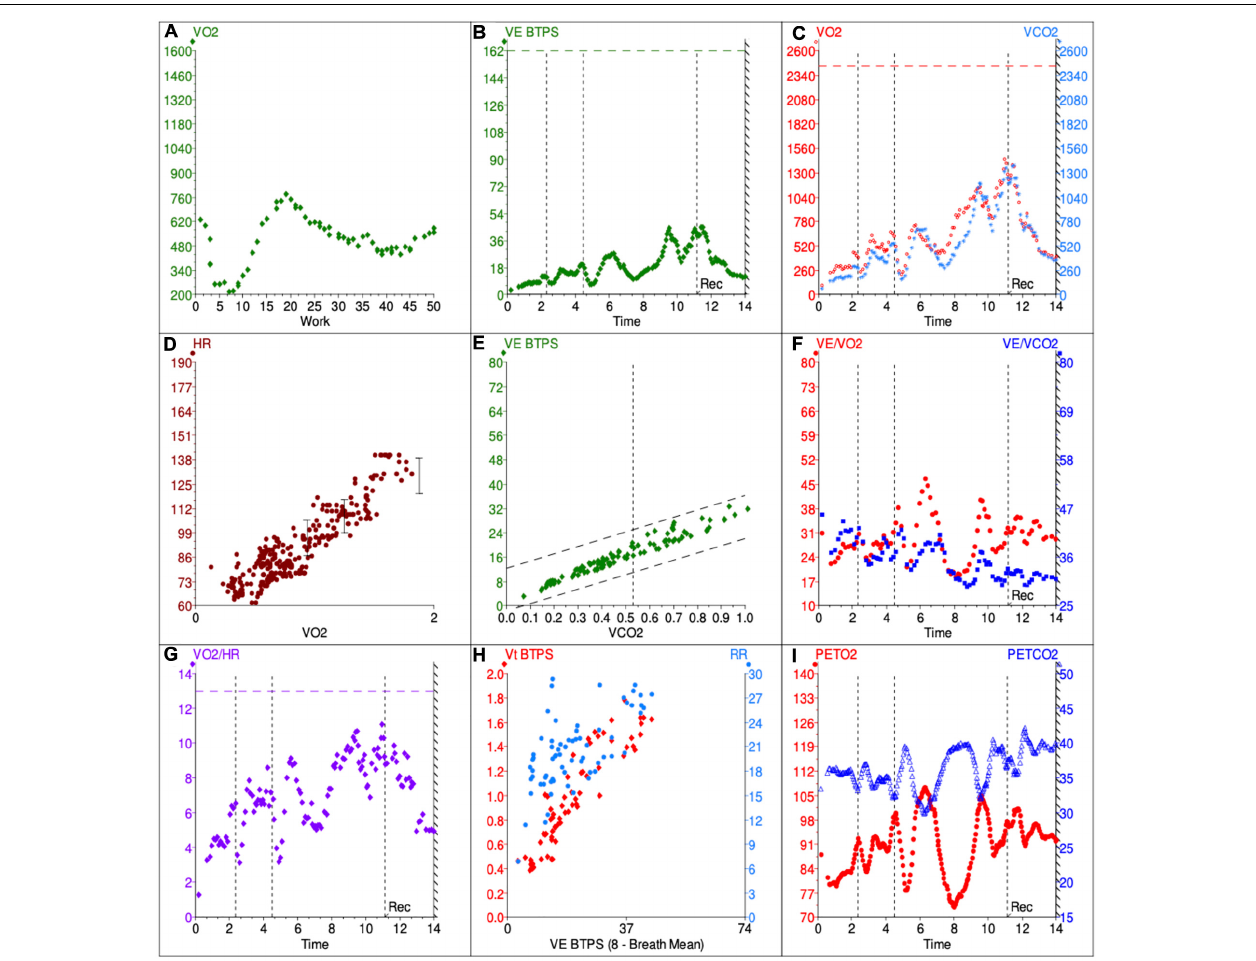
FIGURE 1 | Example 9-panel plot showing patterns consistent with DB. The panels give an overview of metabolic (A,C) , cardiovascular (D,G) , ventilatory (B,E,F,H) and gas exchange (I) responses during the CPET. VO2, volume of O 2 used per minute; VCO2, volume of CO2 produced per minute; VE, minute ventilation; BTPS, body temperature and standard pressure; HR, heart rate, VE/VCO2, ventilatory equivalent for CO 2 ; VE/VO2, ventilatory equivalent for O 2 . PETCO2, end-tidal CO 2 ; PETO2, end-tidal O 2